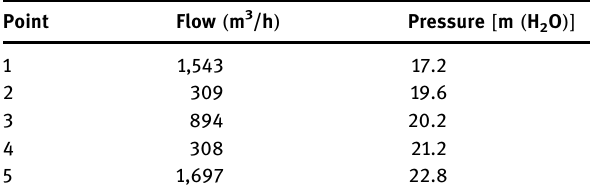
Table 1: Field data for source point Point Flow ( m 3 /h )